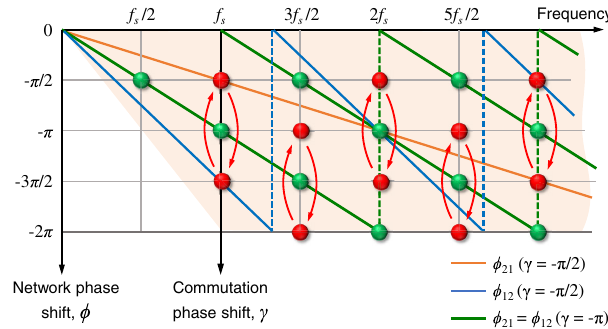
FIG. 7. Achievable phase shifts in the multipath network shown in Fig. 1 as a function of the commutation phase shift γ and =N . Green and red markers commutation frequency f , for τ ∼ T s s indicate reciprocal and nonreciprocal phase shifts, respectively, integer multiples of − π = 2 . Red markers always appear in pairs, indicating phase shifts in opposite directions. The solid green line shows when the phases in two directions coalesce, leading to a reciprocal response. The light shaded area indicates the bounds of the achievable phase